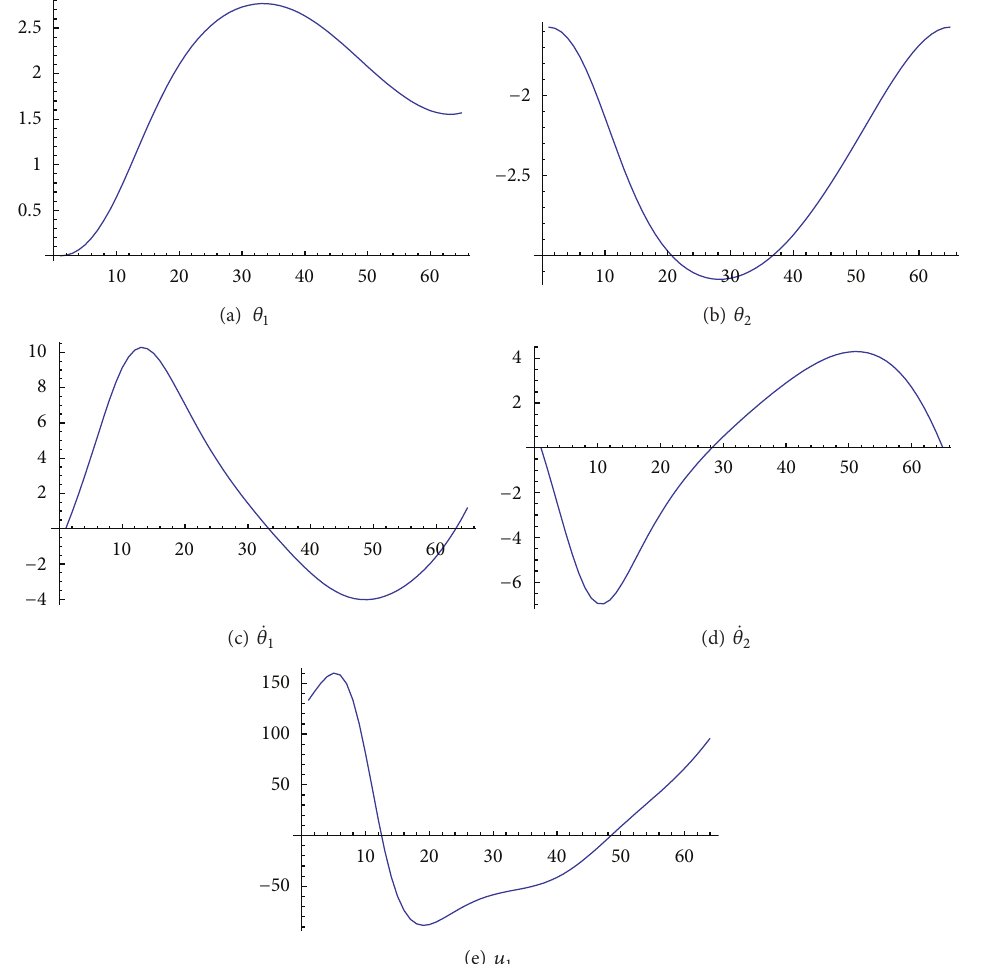
(𝑡 ) = 𝜋/2 [ rad ] , 𝜃 1 𝐹